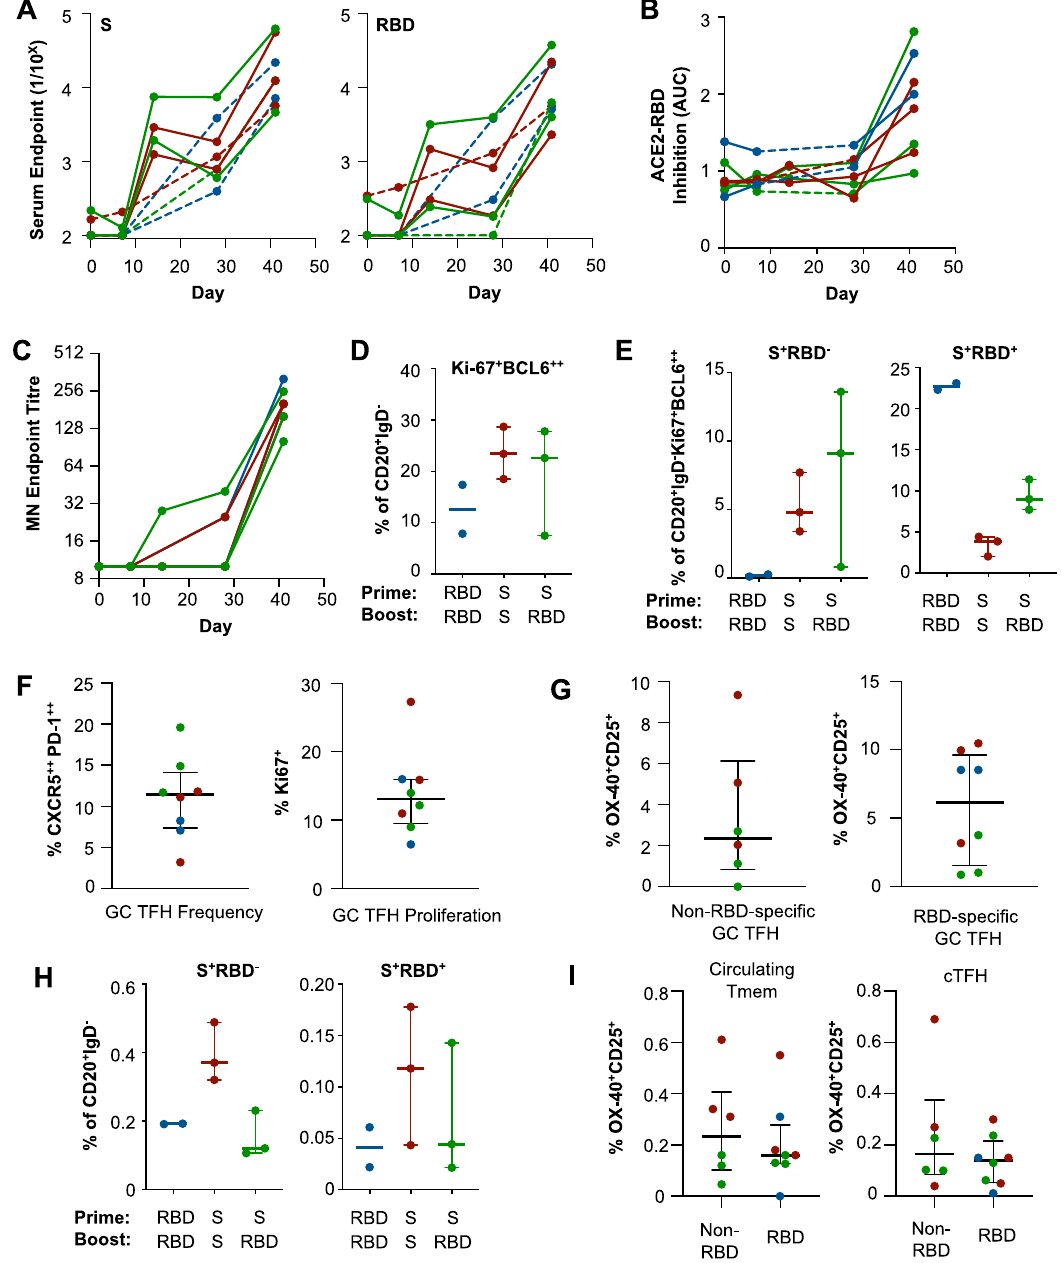
Fig. 3 SARS-CoV-2 spike and RBD immunogens elicit robust B and TFH responses in macaques. Macaques were serially immunised intramuscularly at a 28-day interval with S or RBD immunogens and immune responses assessed 13 – 14 days post boost (R-R in blue ( n = 2), S-S in red ( n = 3) and S-R in green ( n = 3)). Dashed lines indicate animals without day 14 post prime sampling. A Reciprocal endpoint titres of S- or RBD-speci fi c IgG were measured in longitudinal plasma samples by ELISA. B The capacity of plasma antibodies to inhibit the interaction of RBD and human ACE2 was assessed by ELISA. C Neutralisation activity in plasma was assessed using a microneutralisation assay. D Germinal centre CD20 + IgD − B cells were quanti fi ed based on Ki-67 + BCL-6 + expression and frequencies of ( E ) spike- (S + RBD − ) or RBD-speci fi c (S + RBD + ) populations determined by fl ow cytometry. F Frequency of germinal centre TFH cells (CD3 + CD4 + CXCR5 ++ PD-1 ++ ) and Ki-67 + expression in draining lymph nodes. G Antigen-speci fi c TFH cells identi fi ed by OX-40 + CD25 + upregulation following 18h of stimulation with S (minus RBD) or RBD peptide pools. H Frequency of circulating memory B cells within PBMC speci fi c for spike (S + RBD − ) or RBD (S + RBD + ). I Antigen-speci fi c circulating memory CD4 T cells (Tmem; CD3 + CD4 + CD95 + CXCR5 − ) or circulating TFH cells (cTFH; CD3 + CD4 + CD95